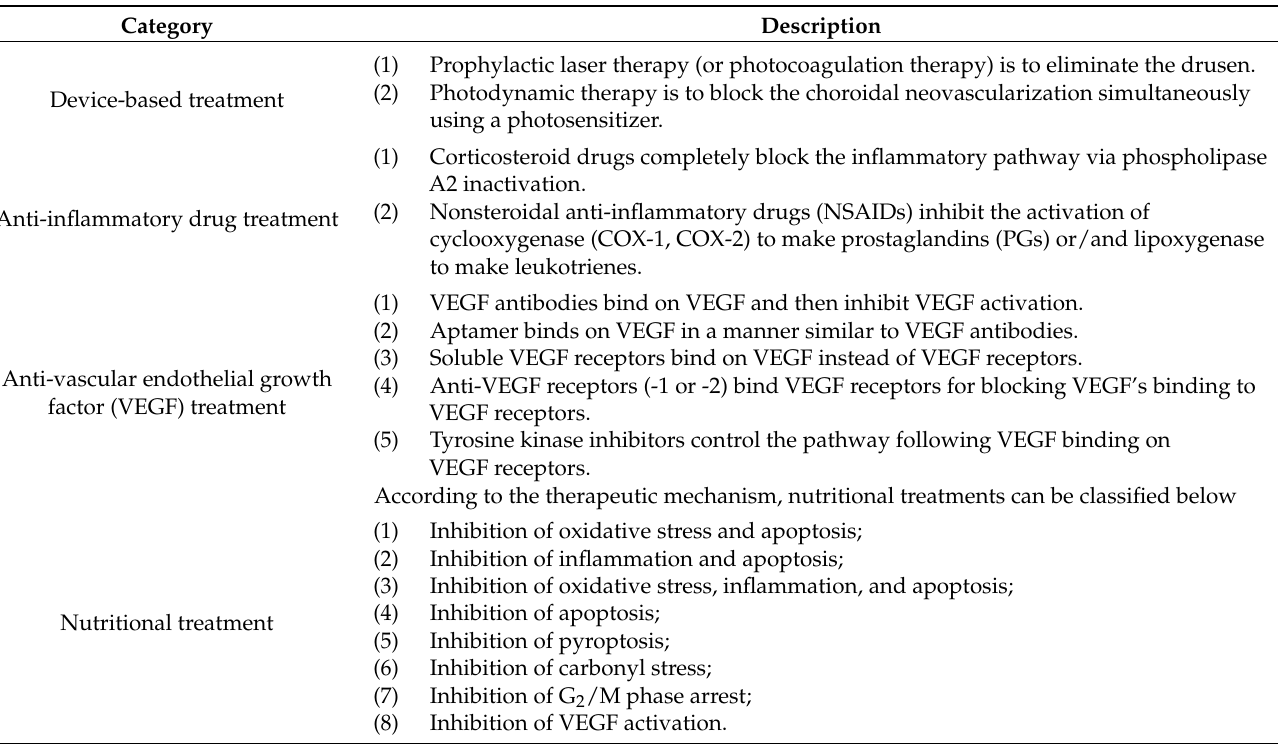
Table 1. The categories of AMD